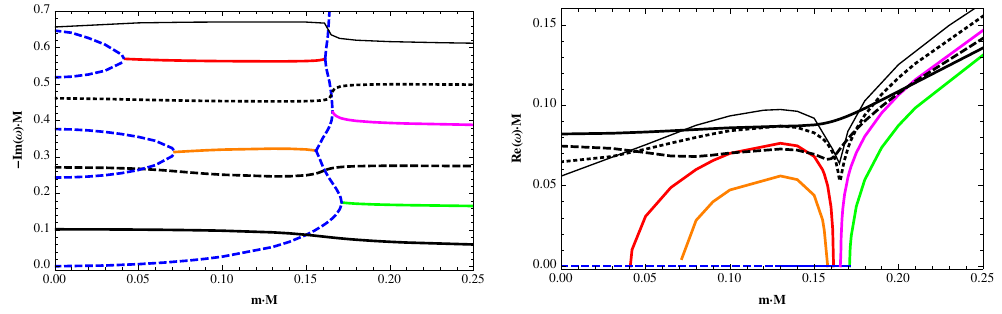
Figure 1 . The behaviour of the QNFs, (cid:0) Im ( ! ) M (left panel), and Re ( ! ) M (right panel), as a function of mM for di(cid:11)erent overtone numbers, with ‘ = 0, and M 2 (cid:3) = 0 : 04. part decay when the angular harmonic numbers ‘ increase; however, for mM > m behaviour is normal, i.e, the longest-lived modes are the ones with smaller angular